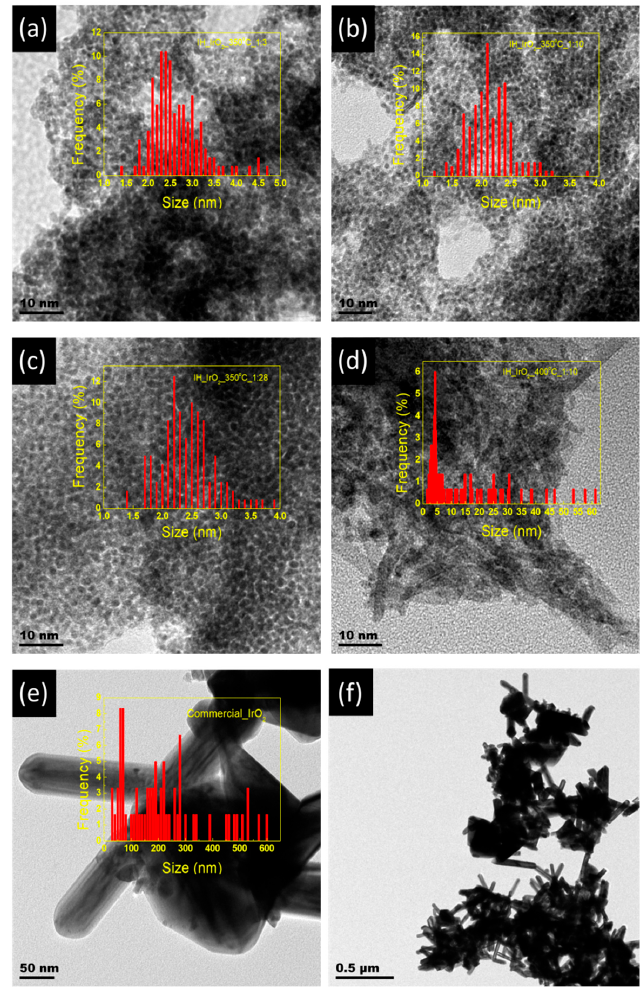
Figure 2. Transmission electron microscope (TEM) images of ( a ) IH_IrO 2 _350 °C_1:3, ( b ) IH_IrO 2 _350 °C_1:10, ( c ) IH_IrO 2 _350 °C_1:28, ( d ) IH_IrO 2 _400 °C_1:10, ( e , f ) Commercial_IrO 2 .